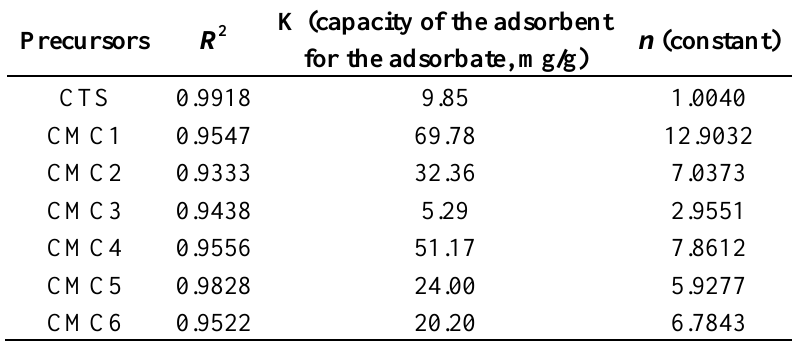
Table 3. Freundlich isotherm parameters for adsorption of Zn 2+ by different chitosans.